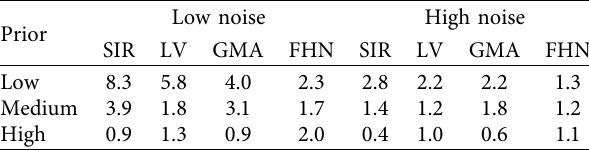
Table 1: MSE ratios for linear parameters (small samples).